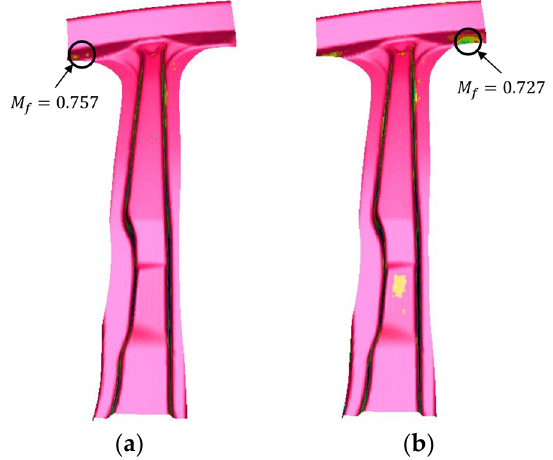
Figure 14. The position and minimum value of the martensite phase ratio at 30 s after stamping and die quenching for ( a ) part from sheet blank thickness of 1.8 mm and ( b ) part from sheet blank thickness of 2.1 mm.